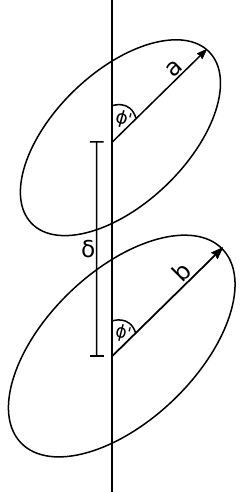
Figure 2. Two rings displaced by δ and both tilted by the same angle φ